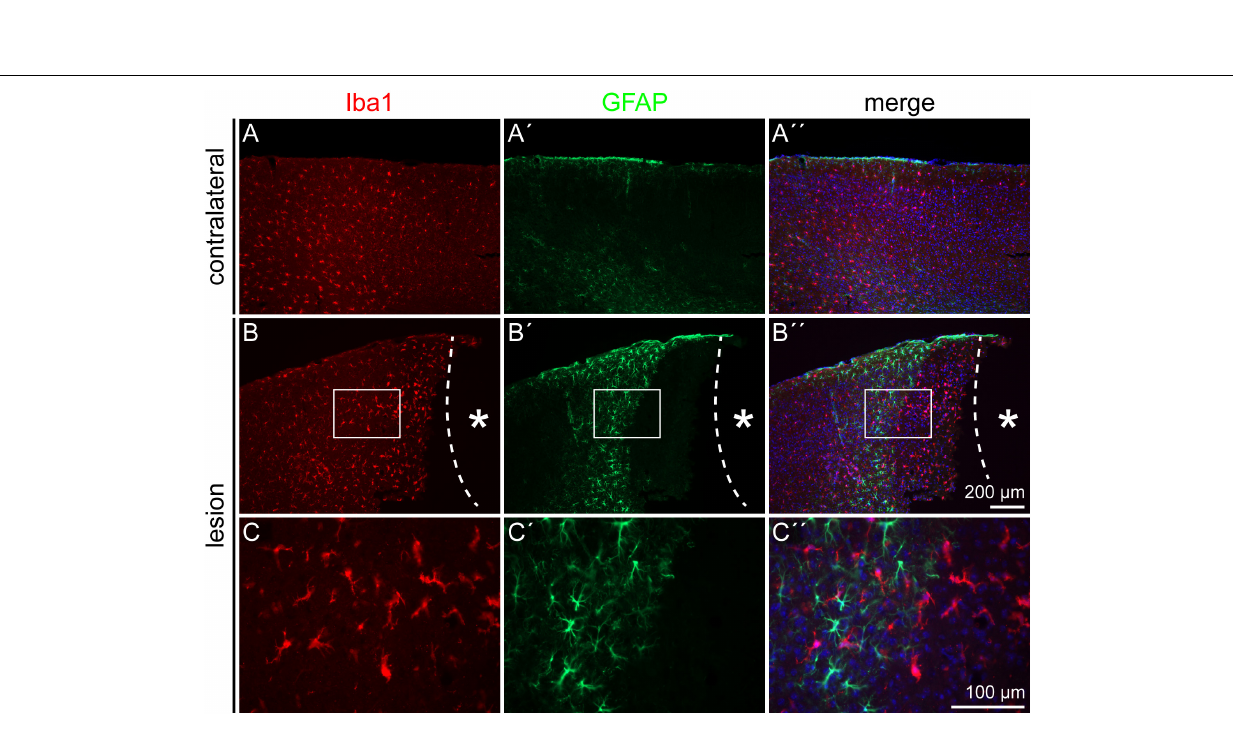
Frontiers in Cellular Neuroscience |